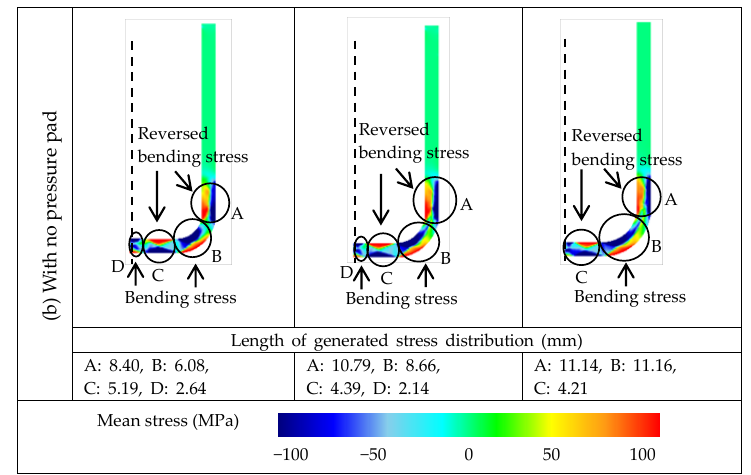
Figure 10. Comparison of the predicted spring-back/spring-go characteristics between the cases of U-bending, with and without pressure pads, with respect to tool radius ( θ : 90°, W : 30 mm, t : 3 mm, WP L : 120 mm, R ud : 5 mm).